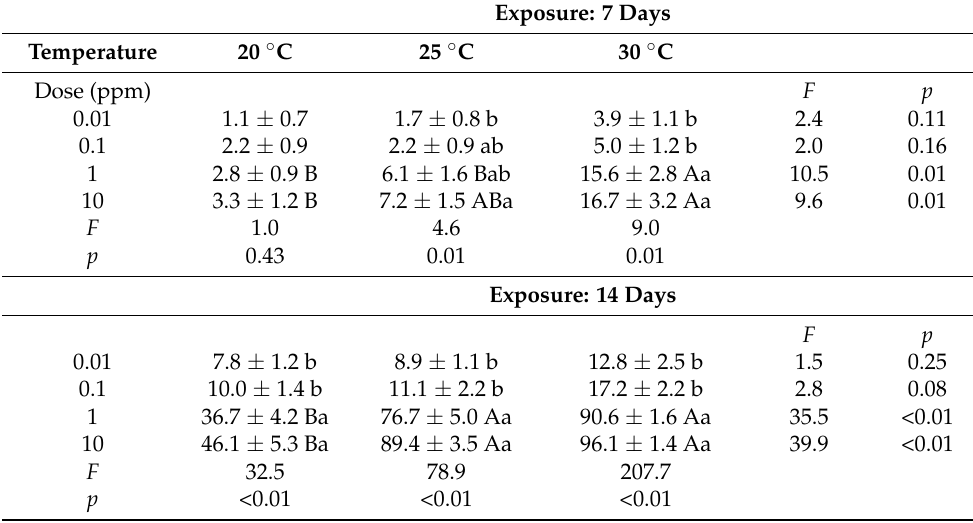
Table 3. Mean mortality (% ± SE) of Prostephanus truncatus adults after 7 and 14 days on maize treated with the SC formulation of chlorantraniliprole, at four doses (0.01, 0.1, 1 and 10 ppm) under three temperatures (20, 25 and 30 ◦ C). Within each column, means followed by the same lowercase letter are not significantly different (in all cases DF = 3, 35, Tukey–Kramer HSD test at 0.05). Within each row, means followed by the same uppercase letter are not significantly different (in all cases DF = 2, 26, Tukey–Kramer HSD test at 0.05). Where no letters exist, no significant differences were recorded. Exposure: 7 Days